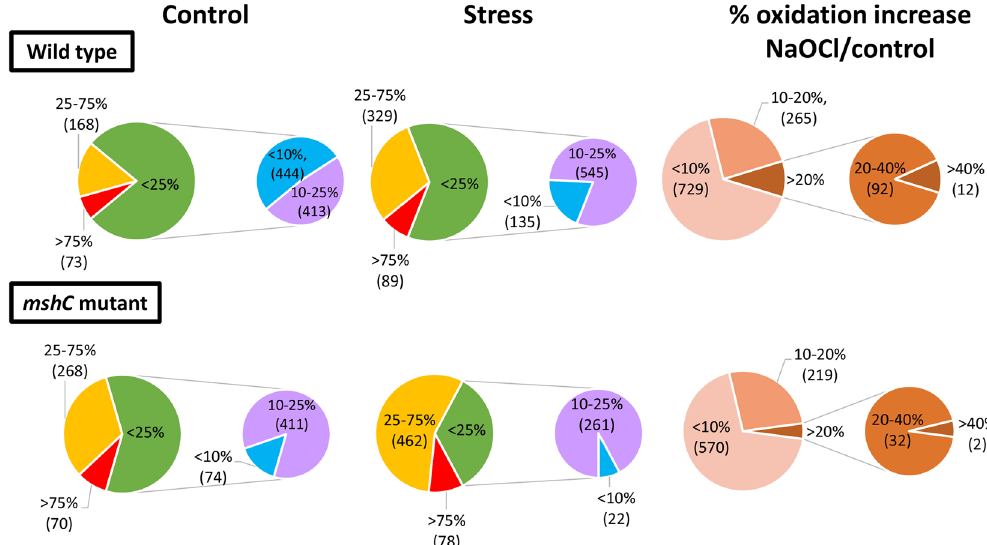
Figure 4. Overview of the percentages of thiol-oxidation levels of all Cys peptides identified in the redox proteome of the M. smegmatis wild type and the mshC mutant under control and NaOCl stress as revealed by OxICAT. Reduced Cys peptides with a < 25% oxidation are shown in green including those < 10% oxidized (blue) and 10–25% oxidized (magenta). Cys peptides with an oxidation degree of > 25% and > 75% are shown in yellow and red, respectively. The percentage of thiol-oxidation increase is shown with an orange-brown color gradient including Cys peptides with 10–20% and > 20% increased oxidation by NaOCl stress. The mshC mutant shows a higher basal level oxidation in the control that resembles that of the wild type after NaOCl